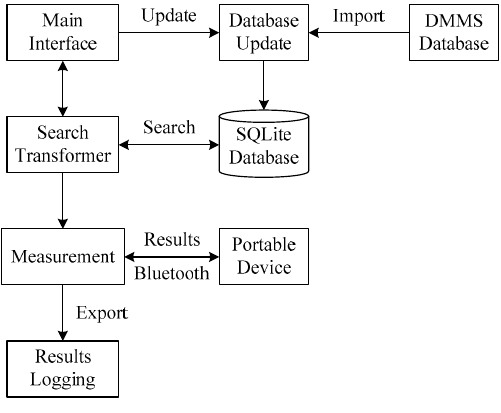
Figure 8. Flow chart of the APP used at the on-site measurement.